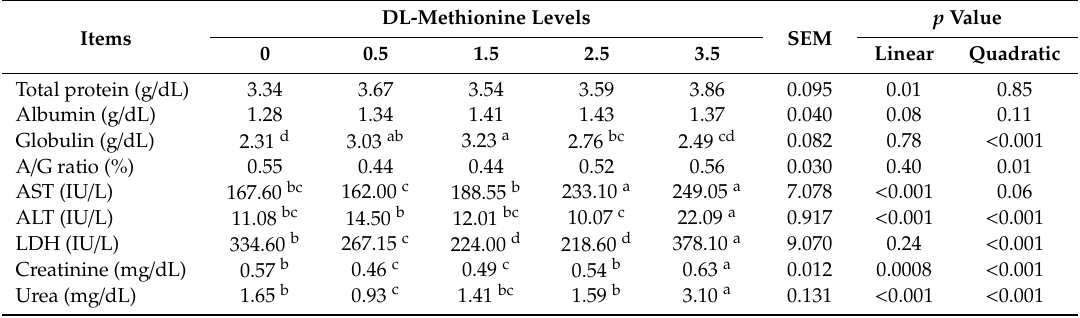
Table 6. Liver and kidney functions of Japanese quail as a ff ected by dietary